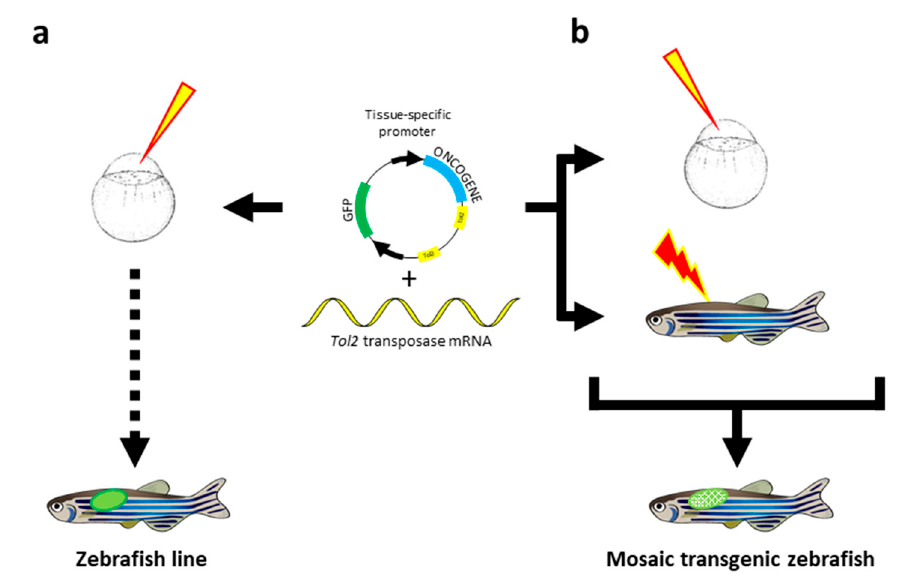
Figure 4. Tol2-mediated transgenesis in zebrafish. ( a ) Stable transgenesis. Transposase mRNA synthesized by in vitro transcription and a plasmid DNA harboring the Tol2 cis regulatory elements (yellow) are co-injected into zebrafish fertilized eggs. The transposase synthesized from mRNA catalyzes the integration of the excised transgenic sequences placed between the Tol2 short terminal repeats into the genome. The injected embryos are raised and crossed with wild-type fish. The integrated transgene is transmitted to the F1 generation showing non-mosaic transgene expression. ( b ) Mosaic F0 transgenic zebrafish can be created either through the microinjection into fertilized eggs or through electroporation in adults (TEAZ) of the Tol2 transposase and the construct containing the cis regulatory elements. A fluorescent marker gene (e.g., GFP) is often present in the construct to identify the transgenics. However, transgenic zebrafish expressing oncogenes could sometime not survive sexual